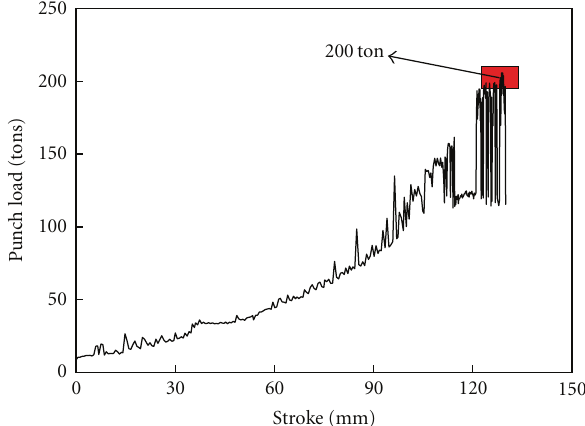
Figure 28: Stress of punch according to stroke for A356 at 588 ◦ C ( S f = 40%) in